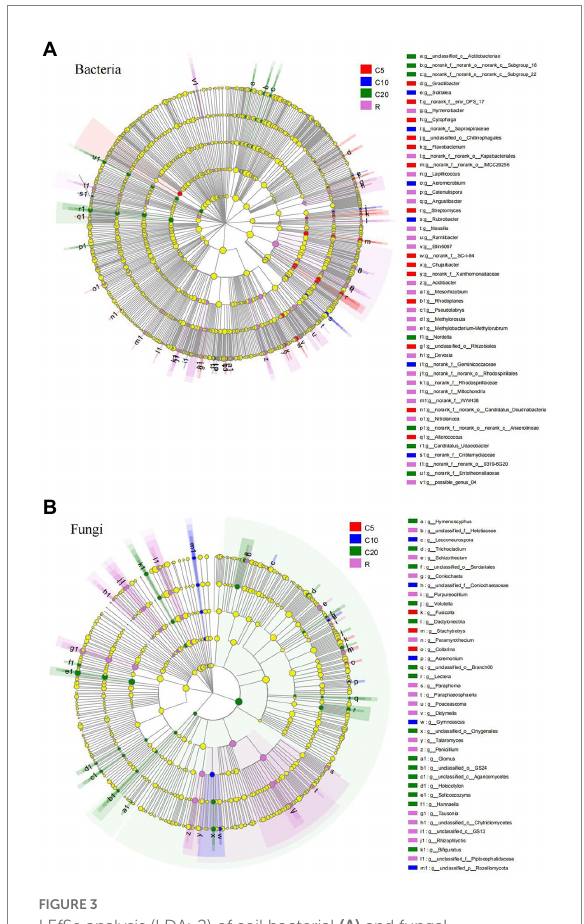
FIGURE 3 LEfSe analysis (LDA > 2) of soil bacterial (A) and fungal (B) communities. The levels of phylum, class, order, family and genus are arranged from the inside to the outside, and the genera are shown in the figure. The yellow circle represents the taxa with no significant difference among the treatments. C5, C10, and C20 represent soybean continuous cropping treatments for 5, 10, and 20 years, respectively, and R represents soybean-corn rotational cropping